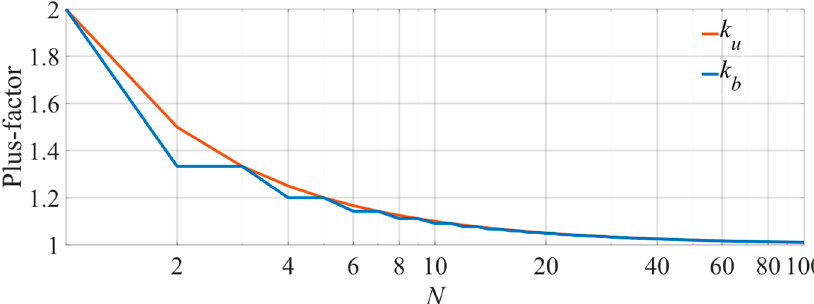
Figure 3. Voltage drop plus factor.